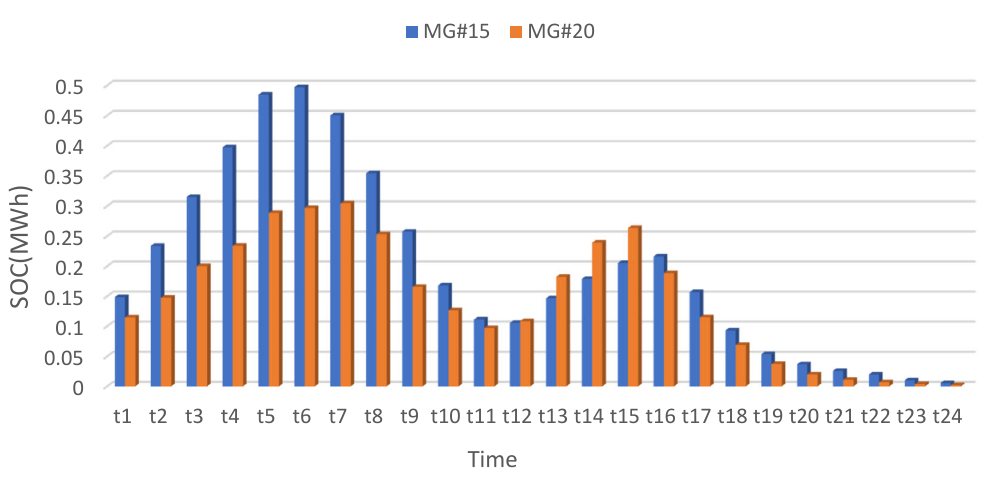
Figure 15. The SOC of PEV ‐ PLs.